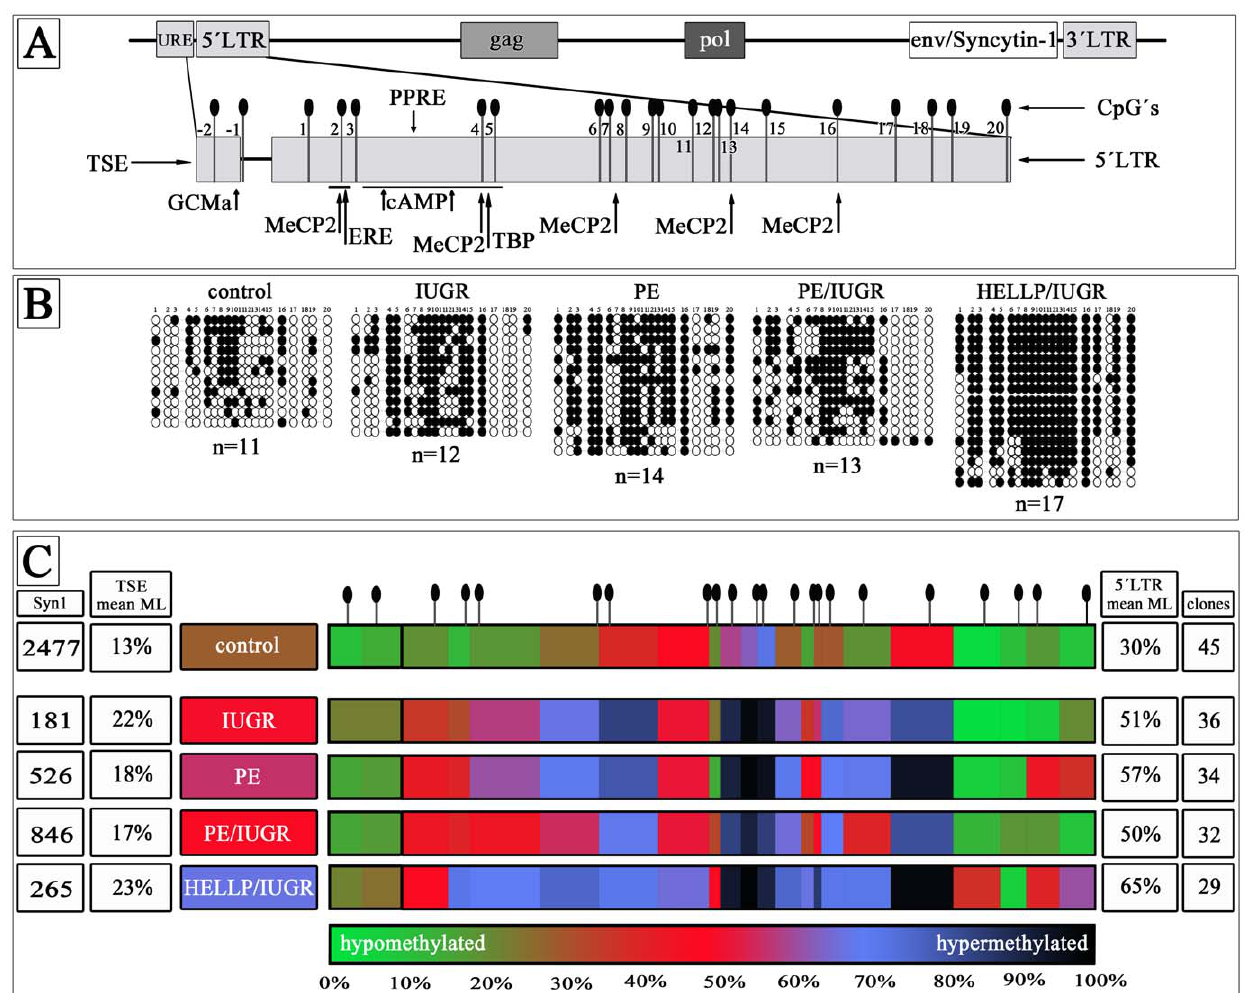
Figure 1. Methylation Profile of the entire promoter of ERVW-1 in isolated trophoblasts. A) Locus of Syncytin-1 on chromosome 7q21.2 within the ERVW-1 gene. Black needles represent the single CpG sides in the promoter. Arrows mark binding sites for transcription factors ore methyl binding proteins B) All sequenced clones of control (n=11), IUGR (n=12), PE (n=14), PE/IUGR (n=13) and HELLP/IUGR (n=17) from one placental trophoblast isolation of each group. White circles represent unmethylated CpGs and black circles methylated CpGs. C) MethylationHeatMap of the promoter region. Mean of three different placentae of each group. Mean of single CpGs are color-coded. From green unmethylated (0%) over red (50% methylated) to black (100% methylated). meanML R mean methylation level of the entire promoter; clones R total analysed clones of each group; Syn1 R mean Syncytin-1 gene expression in mol/ng cDNA.